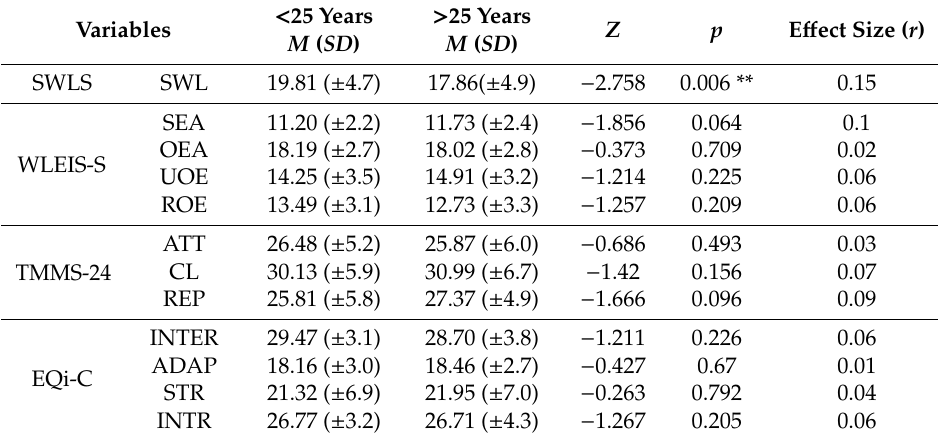
Table 2. Mean di ff erences according to age (U of Mann-Whitney).